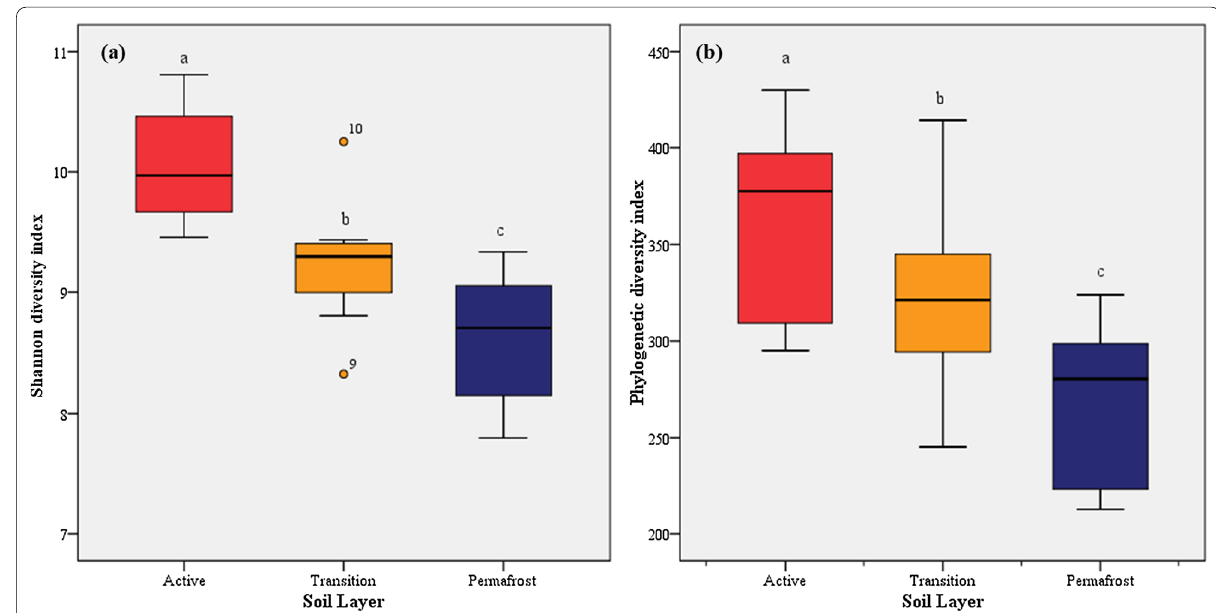
Fig. 4 Box plot based on diversity analysis of soil microbes along soil layers as characterized by ( a ) Shannon diversity index and ( b ) Phylogenetic diversity index